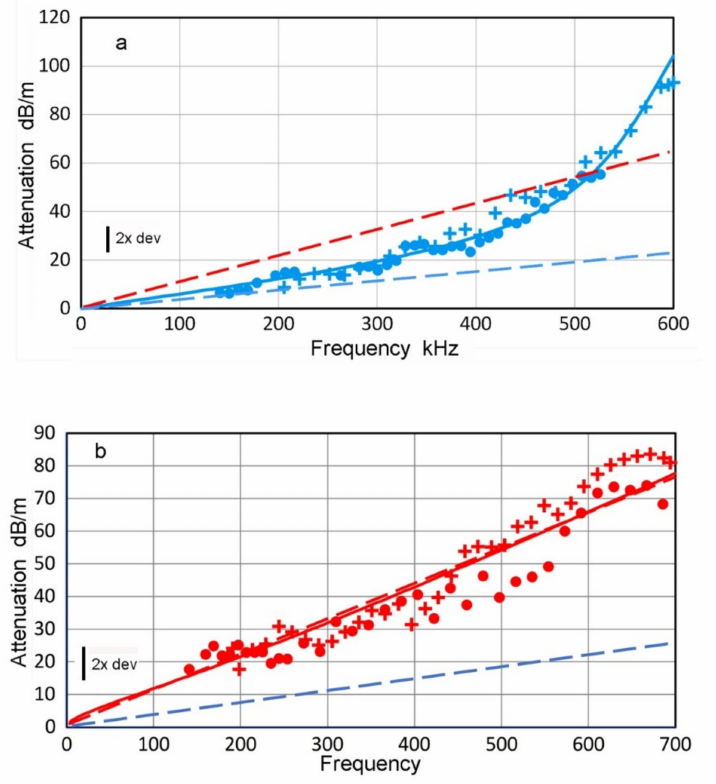
Figure 5. ( a ) α –S o for PS sheets of 1.4-mm thickness in blue symbols. α –S values plotted in dots used Olympus V101 as Tx and + symbols NDT C16 as Tx. KRN-BB-PC was Rx for both. Calculated values of α –S o are plotted in a solid blue curve. Blue and red dashed lines are the bulk-wave attenuation coefficients, α L and α T . Vertical bar indicates twice the value of average deviation or 2 × dev. ( b ) α –A o for PS sheets of 1.4-mm thickness in red symbols. Tx for all three sets used NDT C16 at 60 ◦ incident angle. KRN-BB-PC was Rx for all three. Calculated values of α –A o are plotted in a solid red curve. Blue and red dashed lines are the bulk-wave attenuation coefficients, α L and α T . Vertical bar shows 2 ×